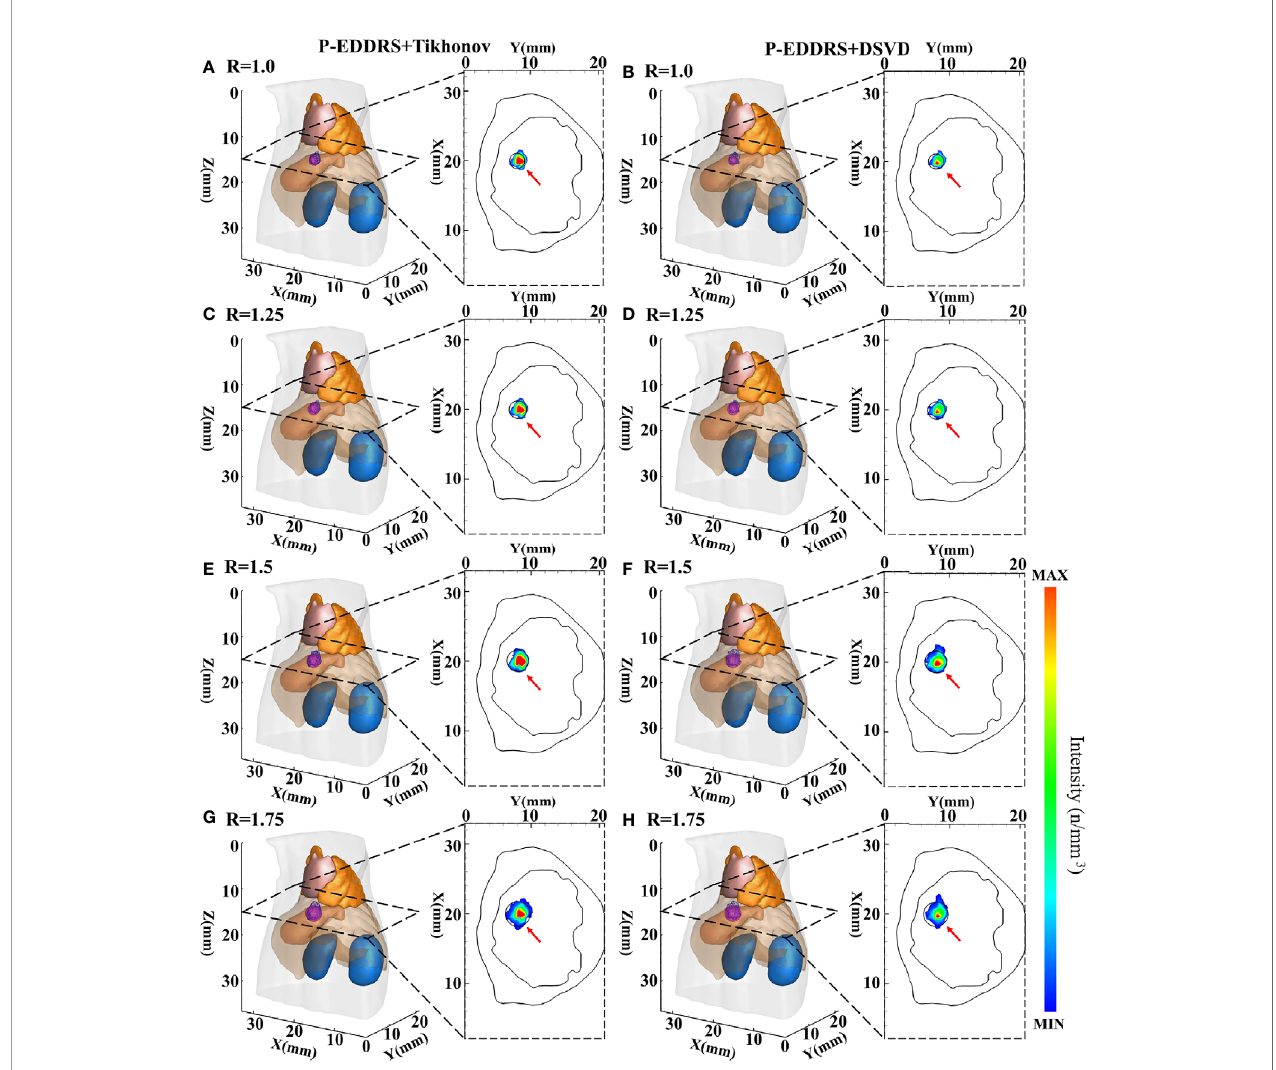
FIGURE 6 | Results of P-EDDRS framework stability and robustness experiment I. All results include 3D views and corresponding cross-section views at the plane of Z = 15 mm (A, C, E, G) . The reconstruction source distribution of spheres with radii of 1.0, 1.25, 1.5, and 1.75 mm combined with Tikhonov algorithm in our framework, respectively (B, D, F, H) . The reconstruction source distribution of spheres with radii of 1.0, 1.25, 1.5, and 1.75 mm combined with DSVD algorithm in our framework, respectively. P-EDDRS, probabilistic energy distribution density region scaling; DSVD, damped singular value